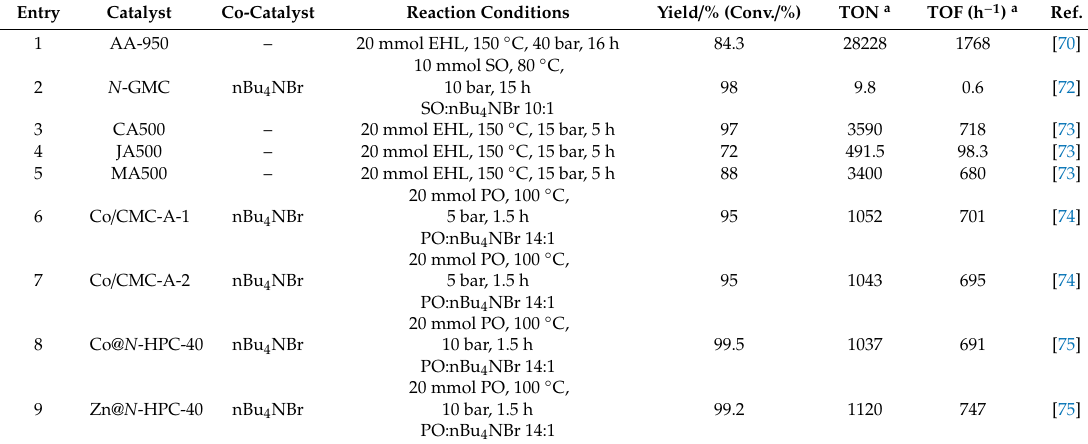
Table 4. Summary of reaction conditions and yields for epoxides conversion to cyclic carbonates using porous carbons materials (propylene oxide (PO), styrene oxide (SO), and epichlorohydrin